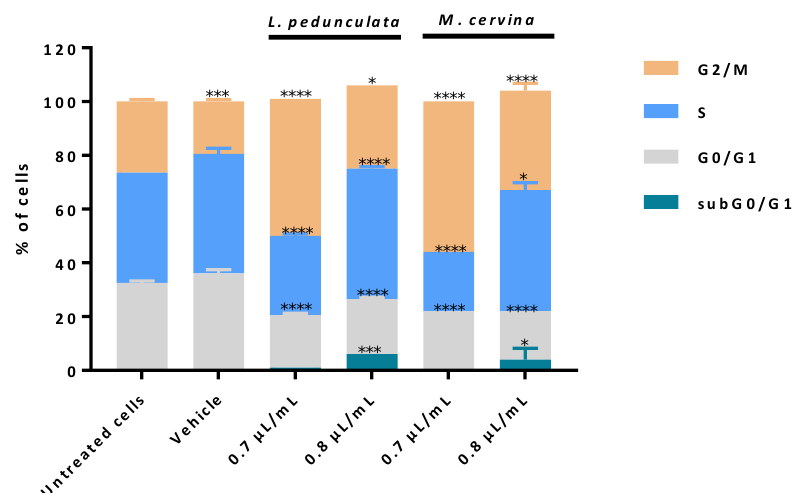
Figure 6. Analysis of cell cycle progression in U87 cell line. Cells were treated either with L. pedunculata EO and M. cervina EO or with the vehicle control (DMSO), and further incubated for 24 h. Cells were stained with PI/RNase solution and cell cycle analysis was assessed by flow cytometry. Proportion of cells in subG0/G1, G0/G1, S and G2/M cell cycle phases was expressed in percentage of total cell population. Asterisks (* p < 0.05, *** p < 0.001, and **** p < 0.0001) represent the values that significantly differ from the control (untreated cells). Data are expressed as mean ± SD.